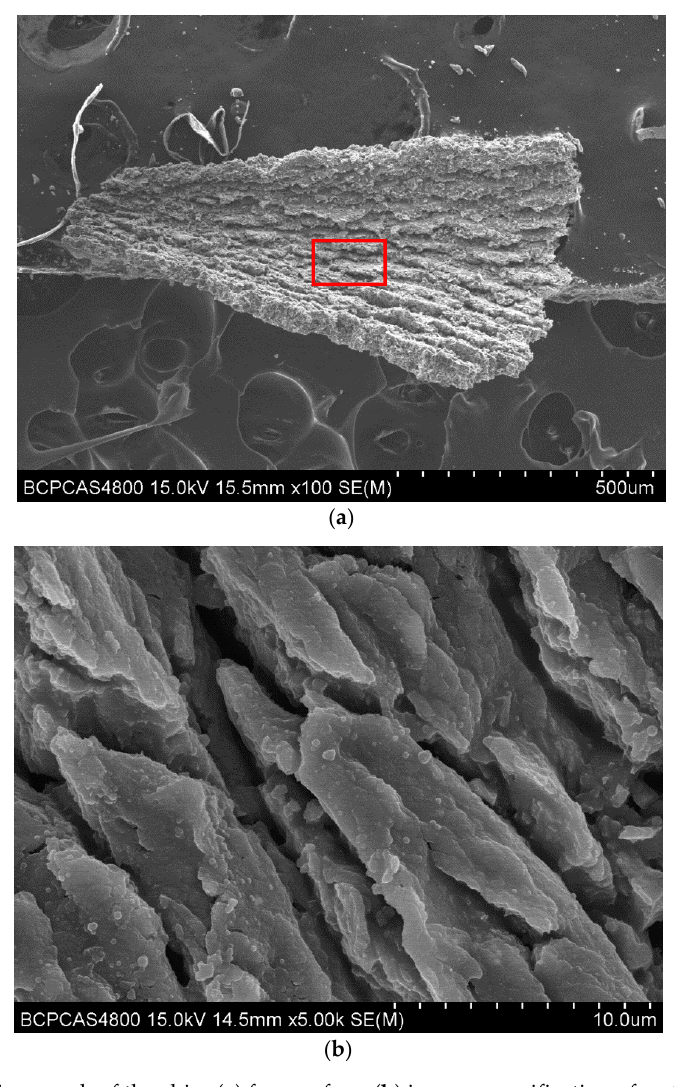
Figure 15. SEM micrograph of the chip: ( a ) free surface, ( b ) image magnification of rectangle region in ( a ).